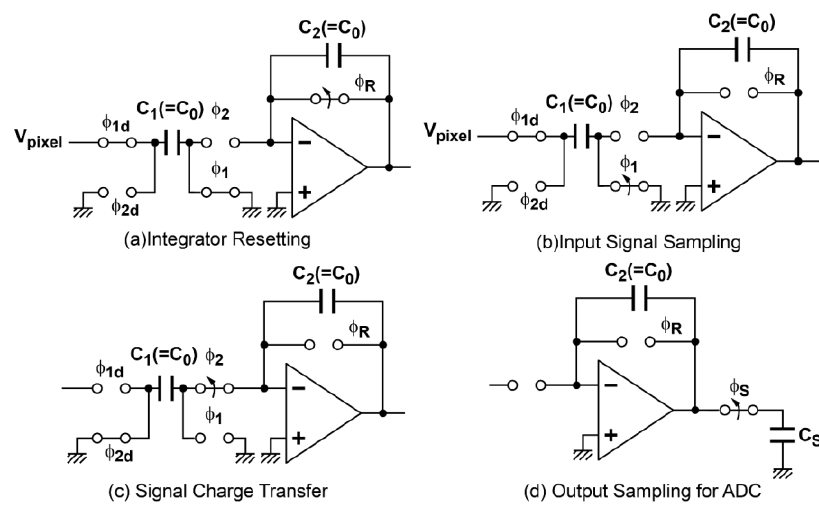
Figure 3. Phase diagram of the column CMS readout circuits.